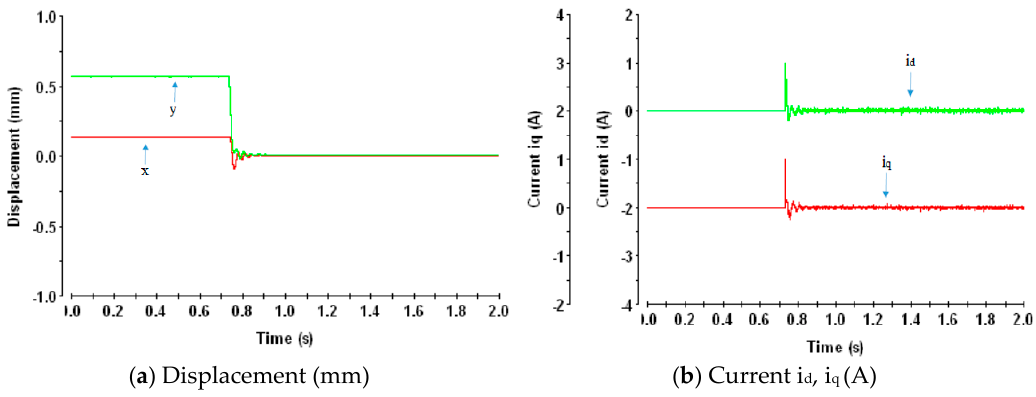
Figure 17. Responses of displacement and bearing currents at zero speed.